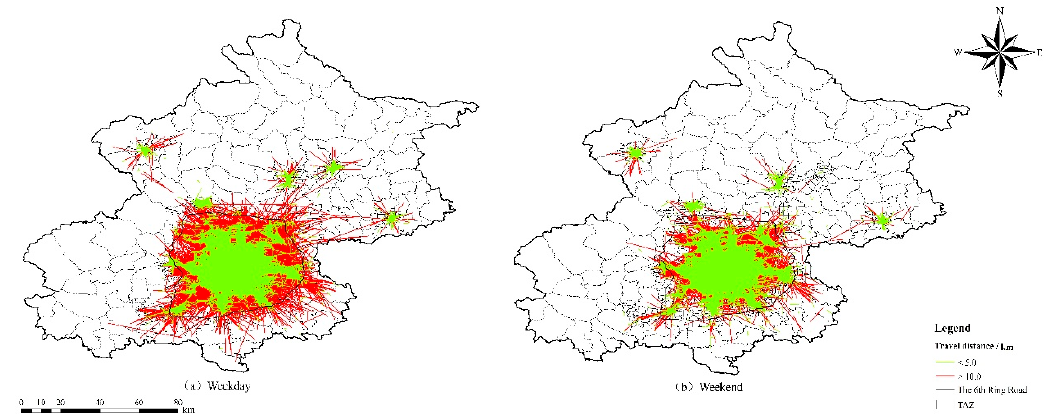
Figure 11. Distribution of travel distance in Beijing based on the TAZ scale.